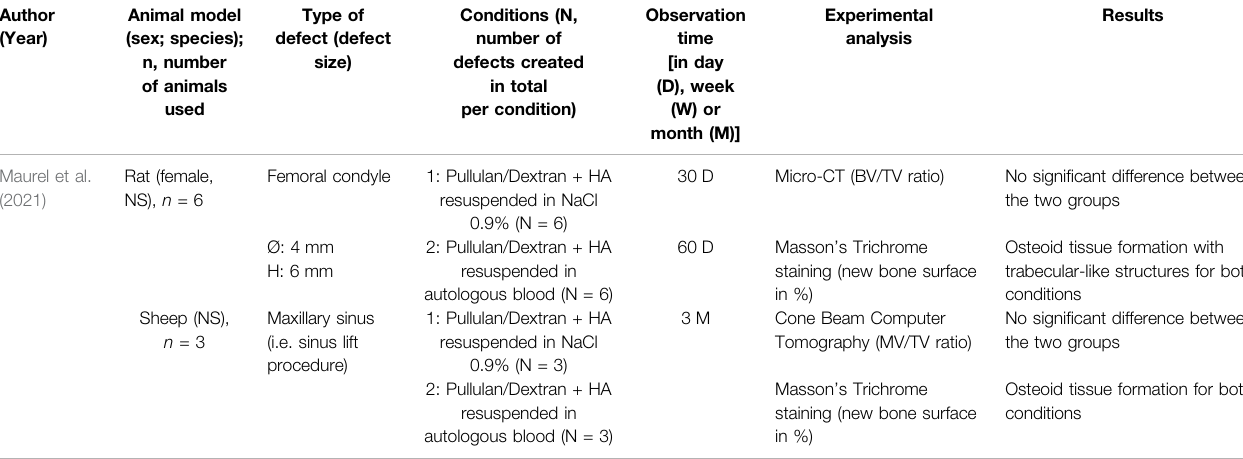
Frontiers in Bioengineering and Biotechnology |